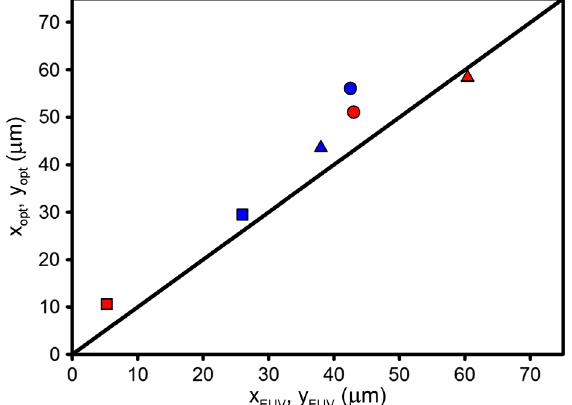
FIG. 11. Comparison of beam sizes obtained in the visible and the EUV spectral regions for different beam configurations. Circles, configuration No. 1; squares, configuration No. 2; triangles, configuration No. 3. Red points: Horizontal (rms) beam size; blue points: vertical beam size. The black solid line indicates the coincidence between the measurements in different spectral